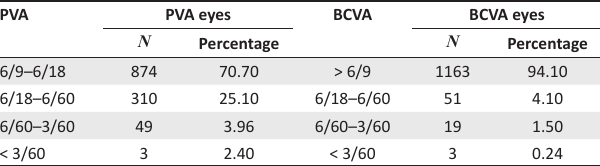
FIGURE 1: Age and sex distribution of TABLE 1: Visual acuity of eyes at presentation.